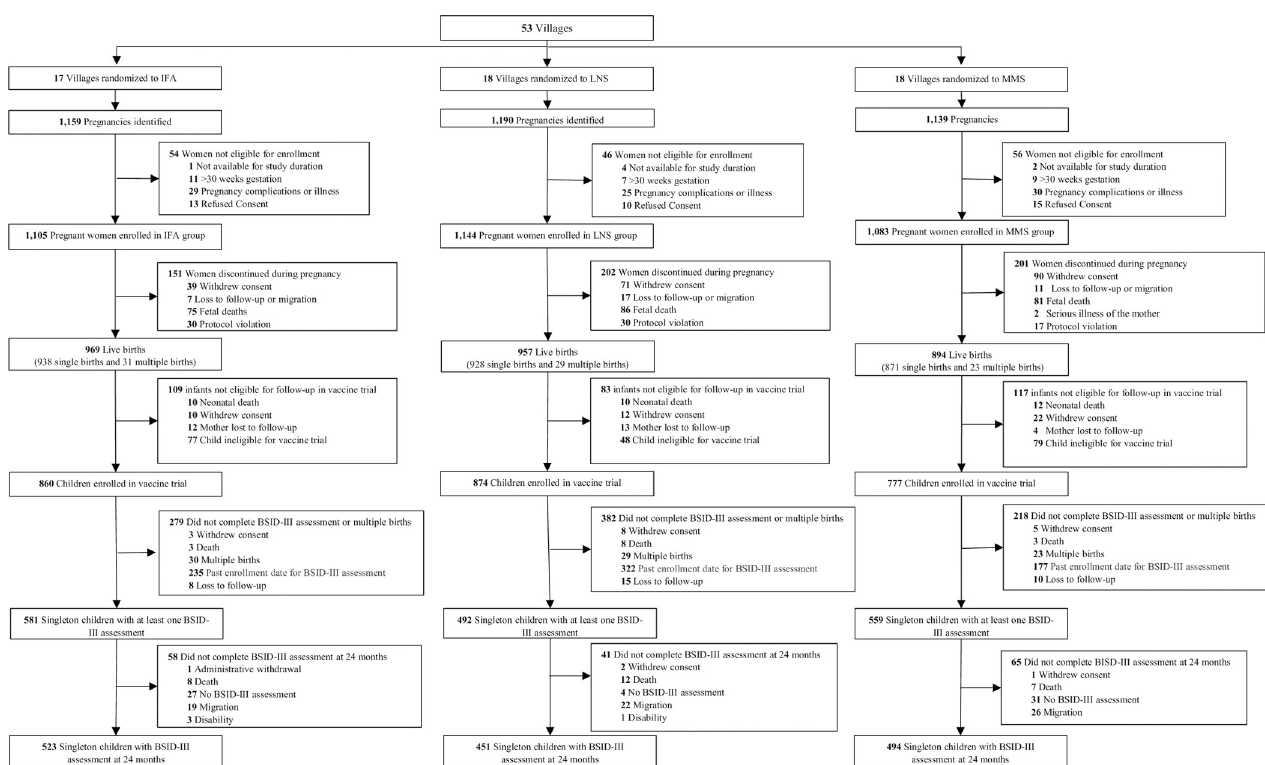
Fig 1. CONSORT flowchart for BSID-III assessments. BSID-III, Bayley Scales of Infant and Toddler Development III; IFA, iron–folic acid supplements; LNS, lipid-based nutrient supplements; MMS, multiple micronutrient supplements; WHO, World Health Organization.